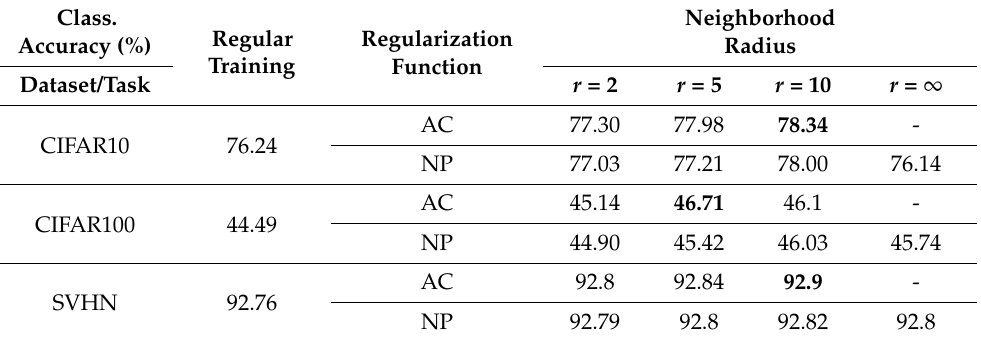
Table 2. Classification accuracy of the student model (Simple CNN) with regular training versus geometric regularization with AC and NP functions for knowledge transfer from a NiN instructor model. Neighborhoods are defined for radius r on the instructor’s MST. The best obtained accuracy for each dataset is indicated in